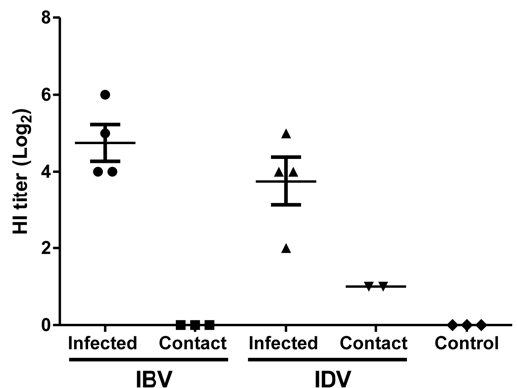
Figure 4. Hemagglutination inhibition (HI) titer of serum samples from contact or pigs infected with IBV or IDV at 8 dpi (6 dpc). HI assay was performed for serum samples collected from three control pigs, three contact pigs, and four infected pigs at 8 dpi based on a standard protocol. HI titer ≥ 20 is judged as positive.